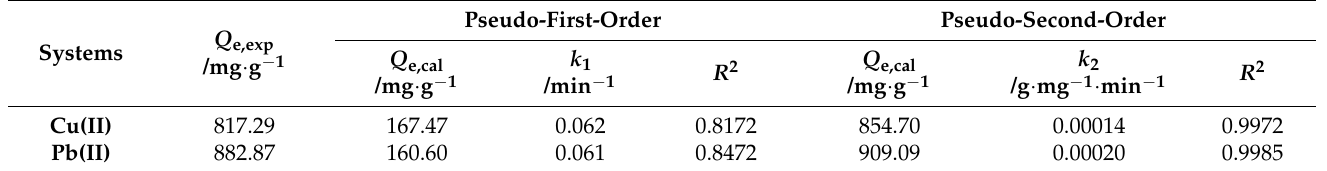
Figure 9. Fitting curves of adsorption kinetics for Cu(II) ( a ) and Pb(II) ( b ) on MOMMC. Table 4. Fitting parameters of adsorption kinetics for Cu(II) and Pb(II) adsorption on MOMMC.